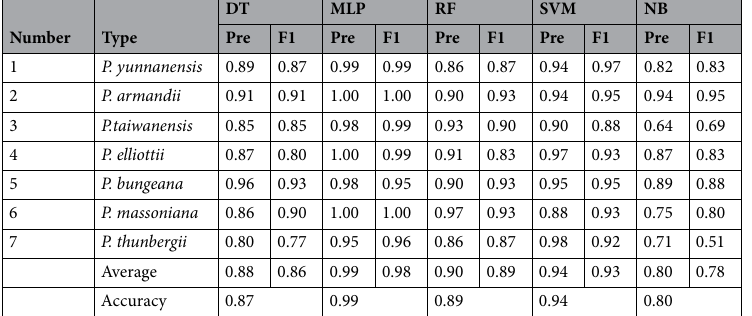
Table 5. Precision and F1 scores of five pine nut classification models with normalized NIR spectral